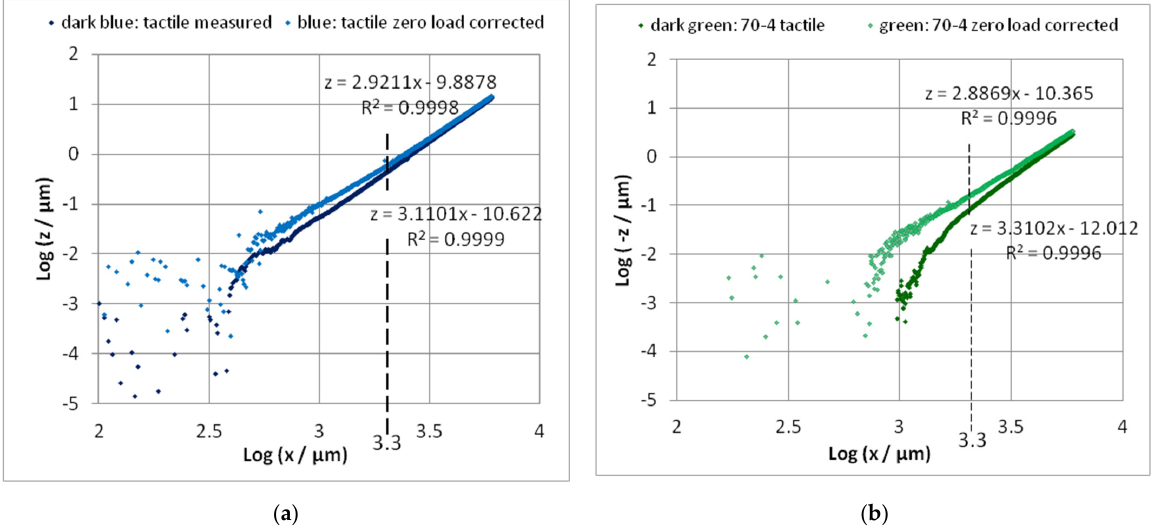
Figure 14. Double logarithmic analysis of the bending line of cantilevers 45-1 ( a ) and 70-4 ( b ). Because the values at the beginning of the cantilevers are strongly scattered (partially negative), the analysis makes sense for x > 2000 μ m (Log 2000 = 3.3). Determination of the slope of the linear part (from 2000 μ m) reveals the power of the bending line.